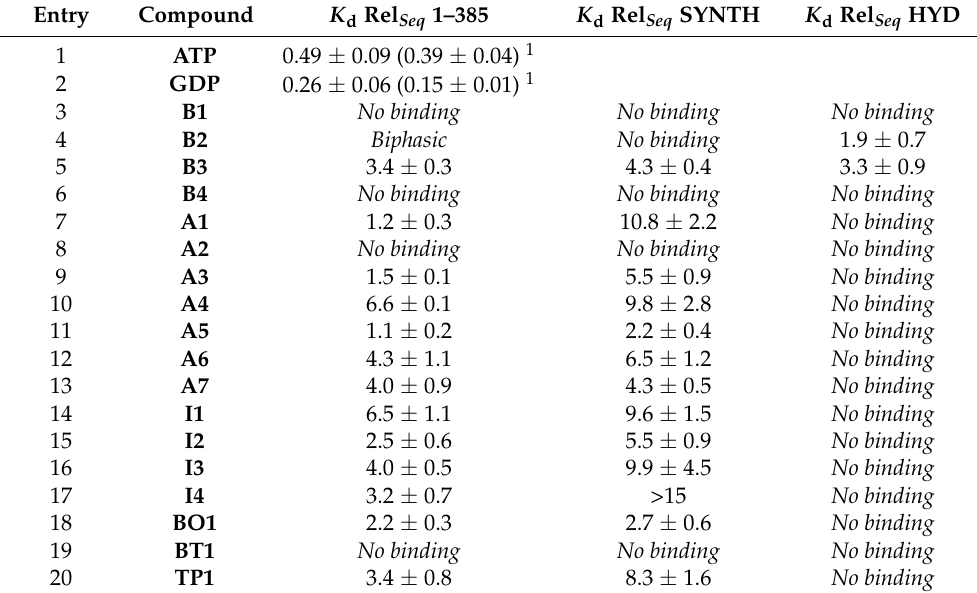
Table 1. Thermal shift assay. K d (mM) of protein–ligand complexes engaged by Rel Seq constructs with the tested